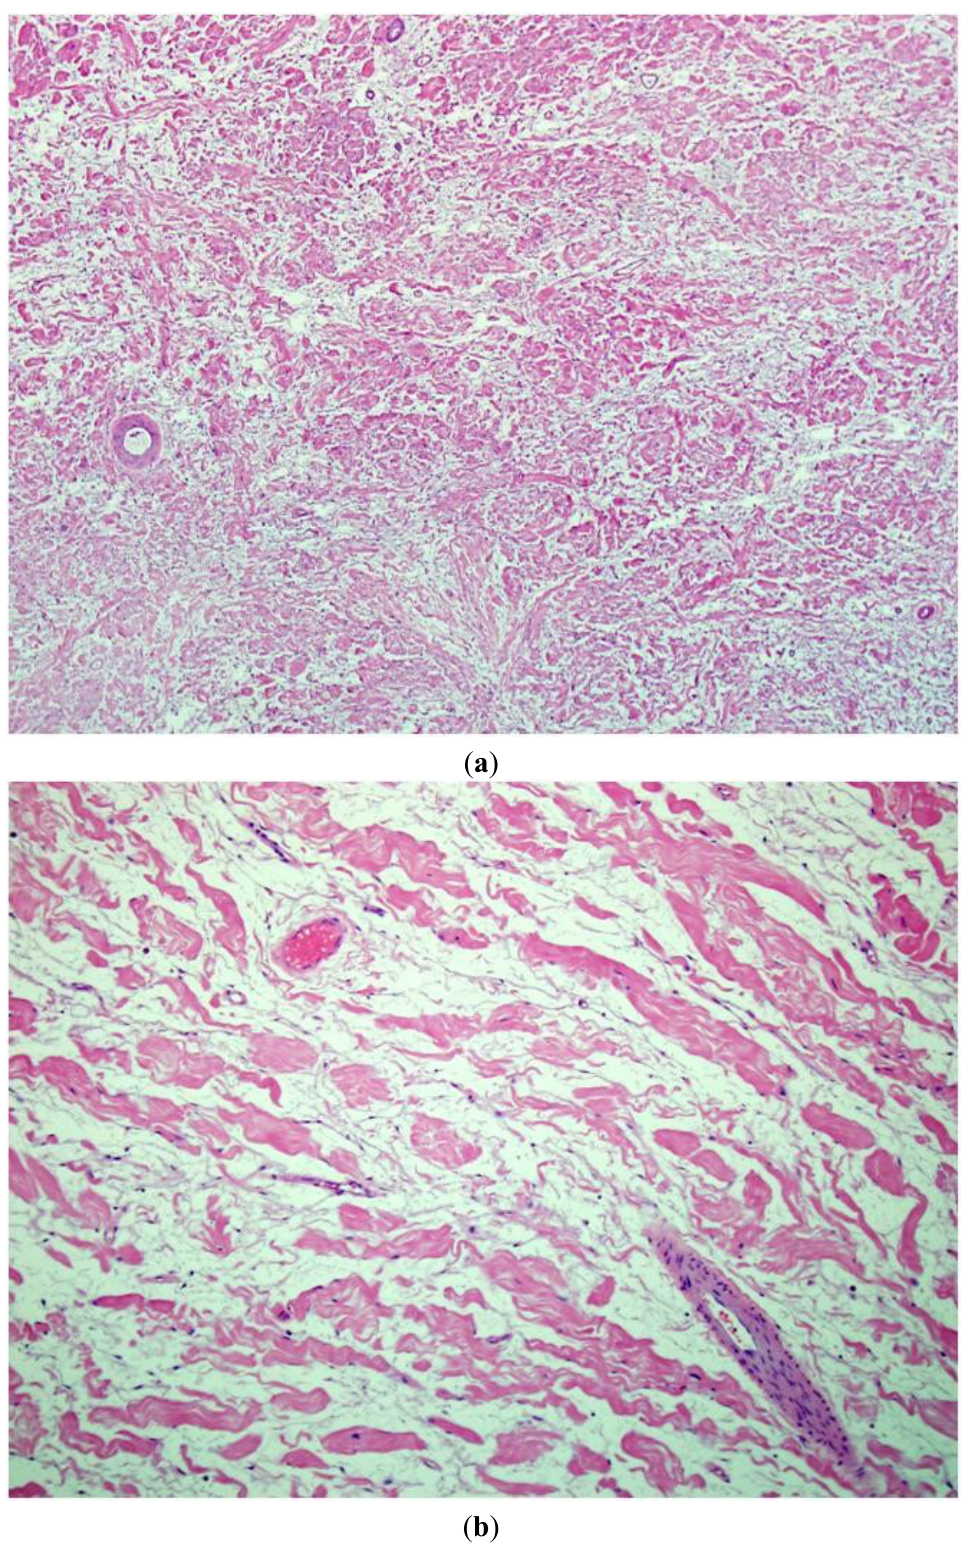
Figure 1. An intermediate (200×) ( a ) and high power view (400×); ( b ) of routine hematoxylin and eosin (H&E stain) sections of typical neurofibromas from an NF1 patient. A low cellularity of spindly (Schwann) cells intermixed with abundant stroma mucin and prominent ―shredded carrot‖ collagen. There is no evidence of cytologic atypia, increased cellularity, or mitotic